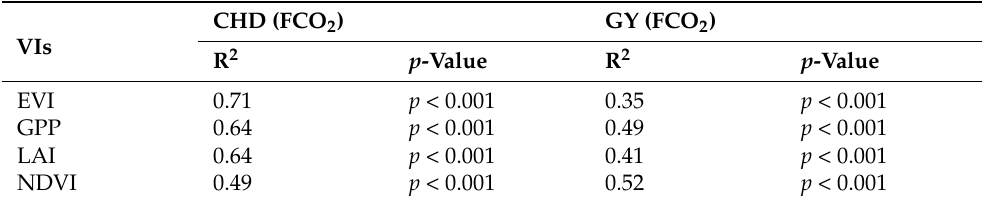
Table 3. Pearson correlation coefficients between the FCO 2 ( n = 35) and the different VIs in the CHD and GY area,